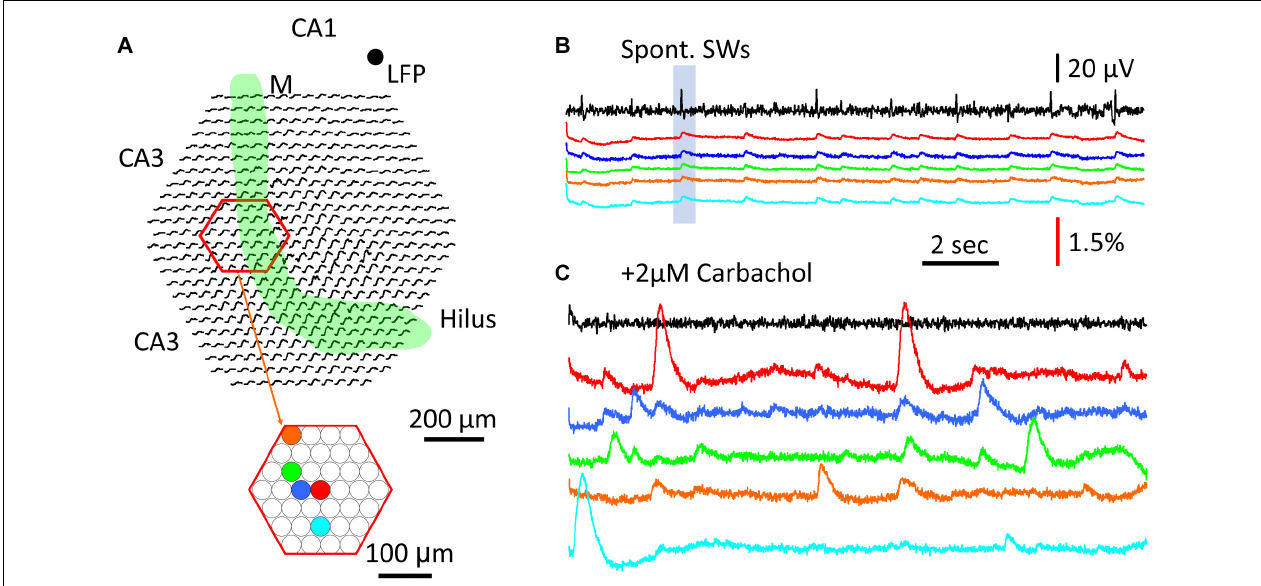
FIGURE 7 | Comparison between cellular transients and population GCaMP signal. (A) Schematic diagram of the imaging field. Green band marks the mossy fiber bundle. Red hexagon marks a subset of optical detectors imaging the CA3 pyramidal cell layer. Color dots mark five individual optical detectors; signals on these detectors are displayed in the color traces in panels (B,C) . (B) Traces of LFP (black) and GCaMP (colors) signals during SW events. LFP was recorded from a location in CA1, marked by the black dot on the top right of panel (A) . Color traces were from optical detectors (color dots in panel A ). Blue box marks the particular SW event with optical recordings from the all detectors (black traces in the imaging field in panel A ), demonstrating that a large fraction of optical detectors around the mossy fiber bundle show SW signals. (C) Cellular Ca 2 + transients recorded from individual detectors in the CA3 pyramidal layer. Color traces are from the same detectors in panels (A) . The signals in panels (B,C) were from the same tissue, during normal ACSF and 2 µ M carbachol, respectively, a low concentration to promote activity but insufficient to induce theta busts. Note that the cellular Ca 2 + transients were often localized to individual detectors, and of high amplitude and longer duration than the population SW signals in panels (A,B)